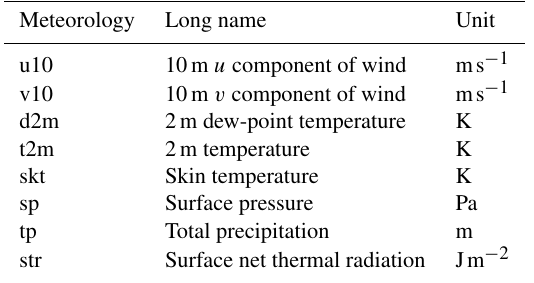
Table 2. Summary of meteorological variables obtained from ERA5-land dataset.